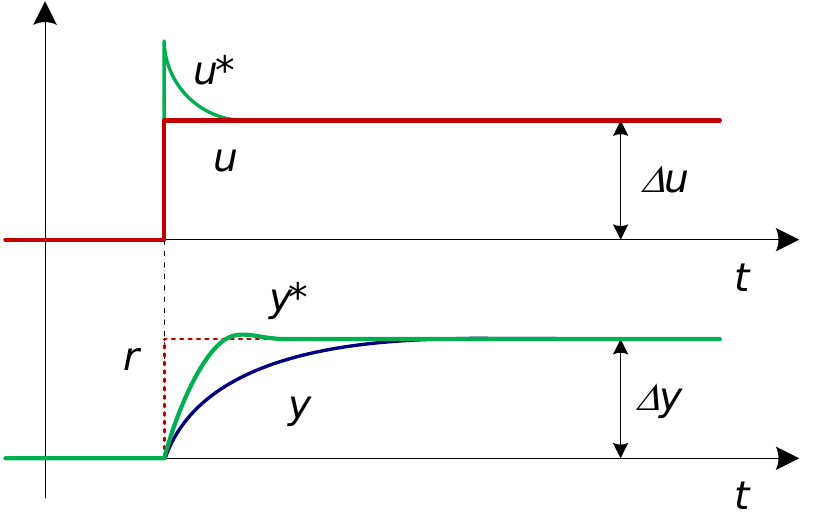
Figure 13. Measured process input ( u ) and output ( y ) signals with artificially calculated reference signal ( r ) (dashed line) represented by r = K PR · u and filtered process input ( u* ) and output ( y* ) signals (solid green lines) during the open-loop experiment.